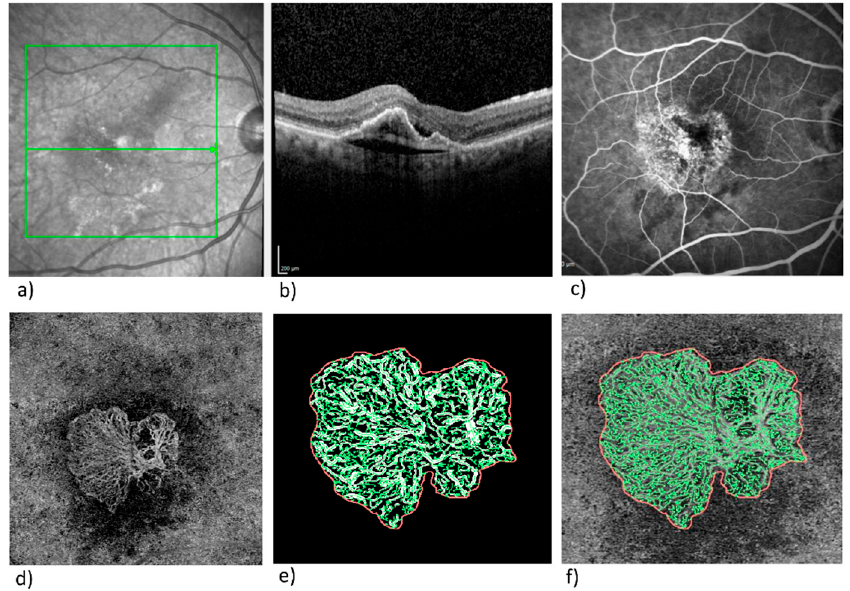
Figure 1. Typical images from patients with newly diagnosed nAMD: ( a ) IR-image with OCT line; ( b ) SD-OCT image; ( c ) FA; ( d ) en-face OCTA in ORCC segmentation; ( e ) binarized MNV; and ( f ) skeletonized MNV.